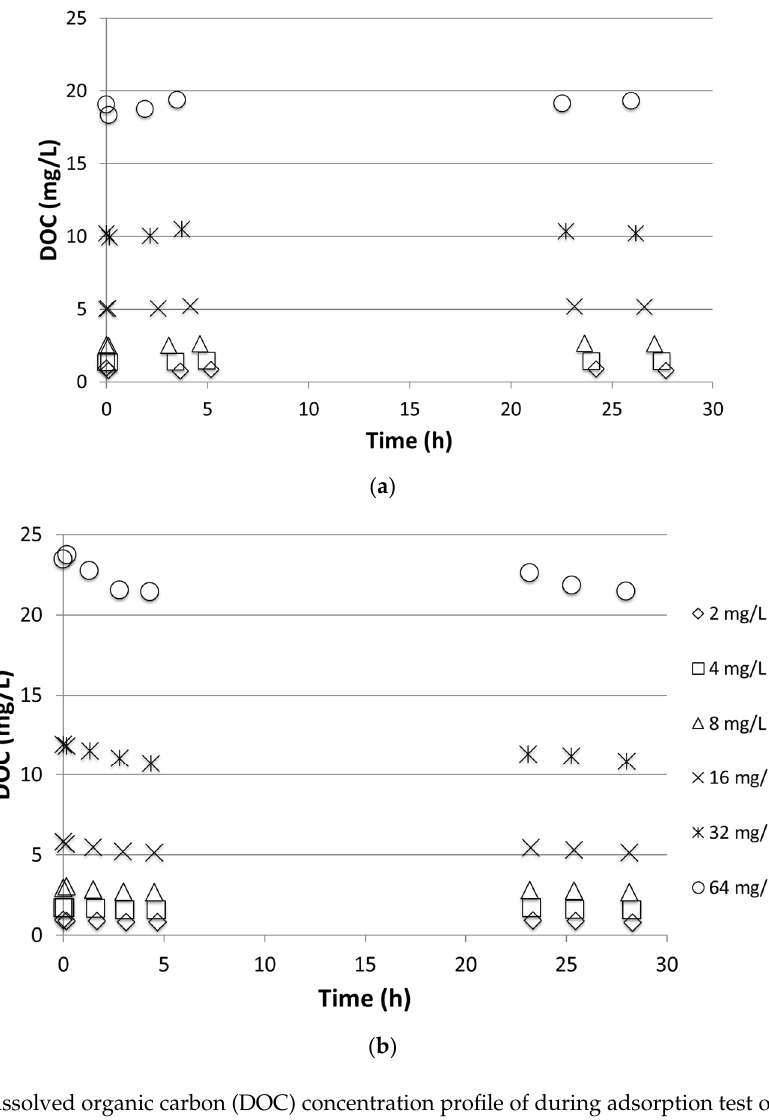
Figure 2. Dissolved organic carbon (DOC) concentration profile of during adsorption test of propylene glycol (PG) onto ( a ) NC 0-2 and ( b ) GAC.